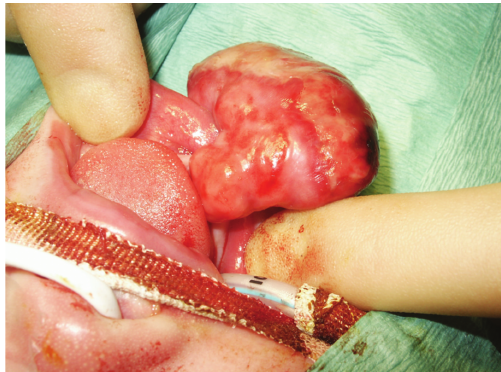
Figure 4: Hematoxylin and eosin stain × 400 showing clusters of cells containing abundant granular eosinophlic cytoplasm and small uninform